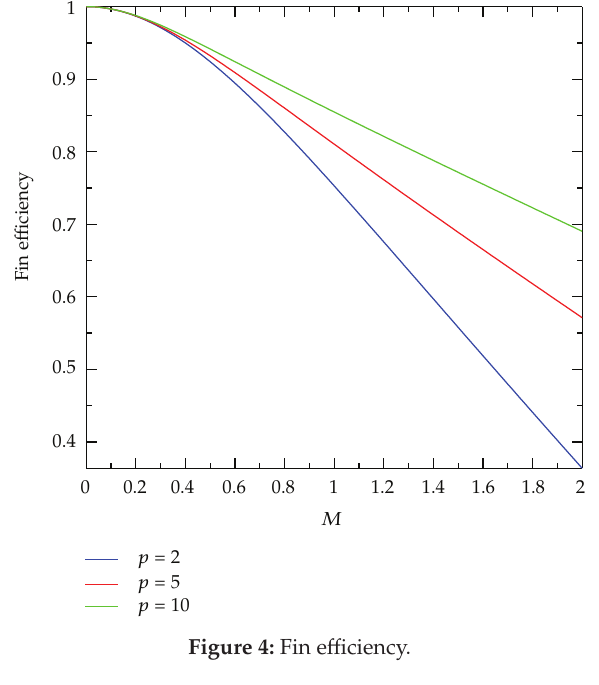
Figure 4: Fin e ffi ciency.